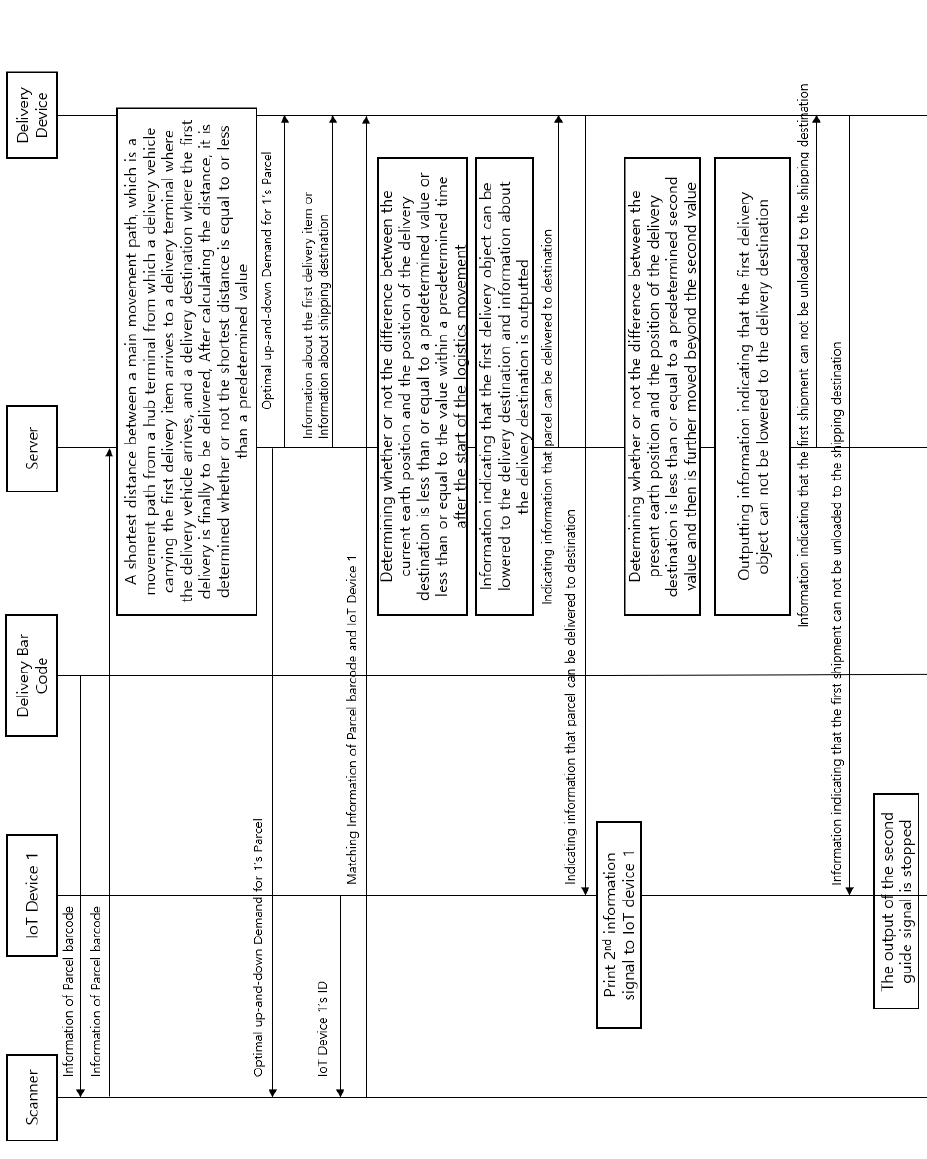
Figure 3. Sequence diagram of Improved Parcel Delivery System: Server